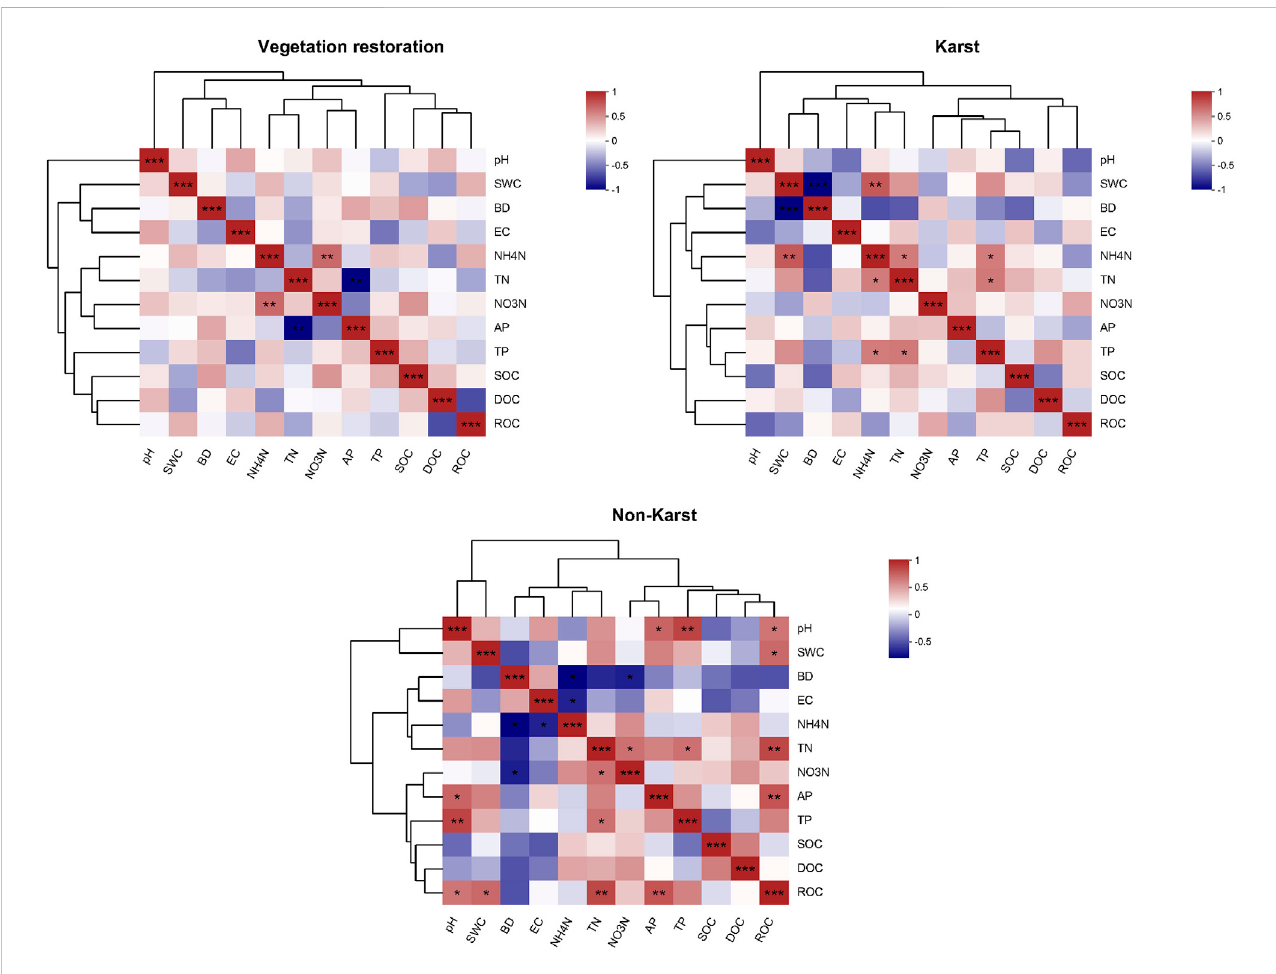
FIGURE 6 Correlation analysis of soil physical and chemical properties by two matrices. * p < 0.1; ** p < 0.05; *** p < 0.01.